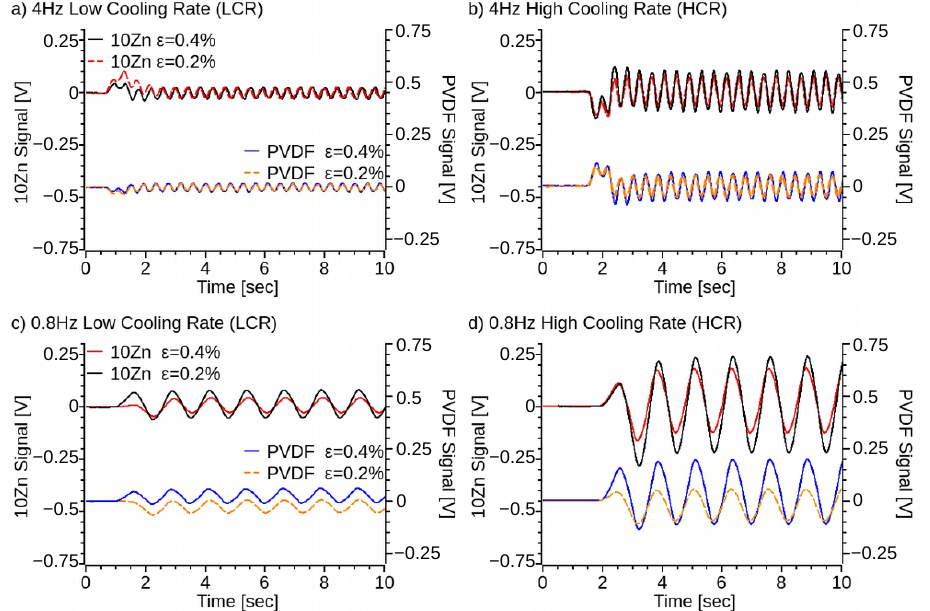
Figure 12. Voltage signal generated by the 3D printed PVDF and ZnO-PVDF in response to a 0.2% and 0.4% sinusoidal strain at a frequency of: ( a ) 4 Hz for LCR samples, ( b ) 4 Hz for HCR samples, ( c ) 0.8 Hz for LCR samples, and ( d ) 0.8 Hz for HCR